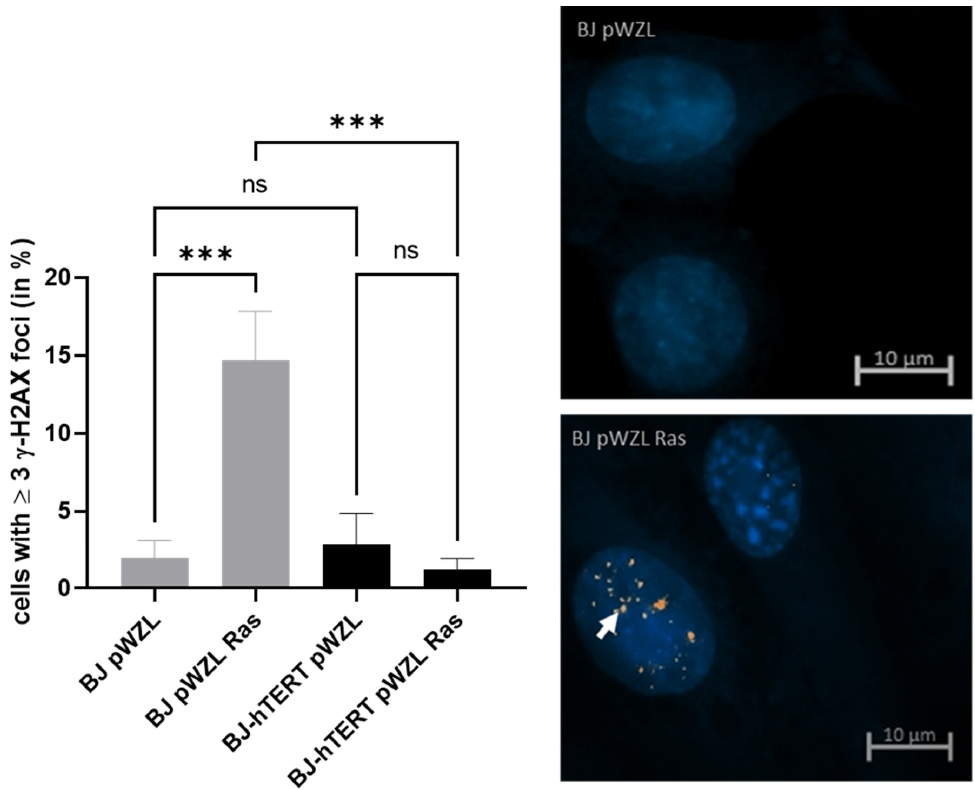
Figure 4. Evaluation of γ -H2AX foci formation upon oncogene-induced replication stress. ( Left ) The bar plot displays the impact of ectopic H-RAS G12V on γ -H2AX foci formation in BJ and BJ-hTERT cells. pWZL represents the empty vector control. One-way ANOVA test was applied, followed by a Fisher’s LSD post hoc test, with a confidence interval of 95%. ( Right ) Representative images of BJ-pWZL (top) and BJ pWZL-RAS (bottom). A total of 200 cells were counted from n = 4 independent experiments. The representative pictures show DAPI stained nuclei with nuclear pRPA2 foci (white arrow). ns ( p > 0.05), *** ( p ≤ 0.001).